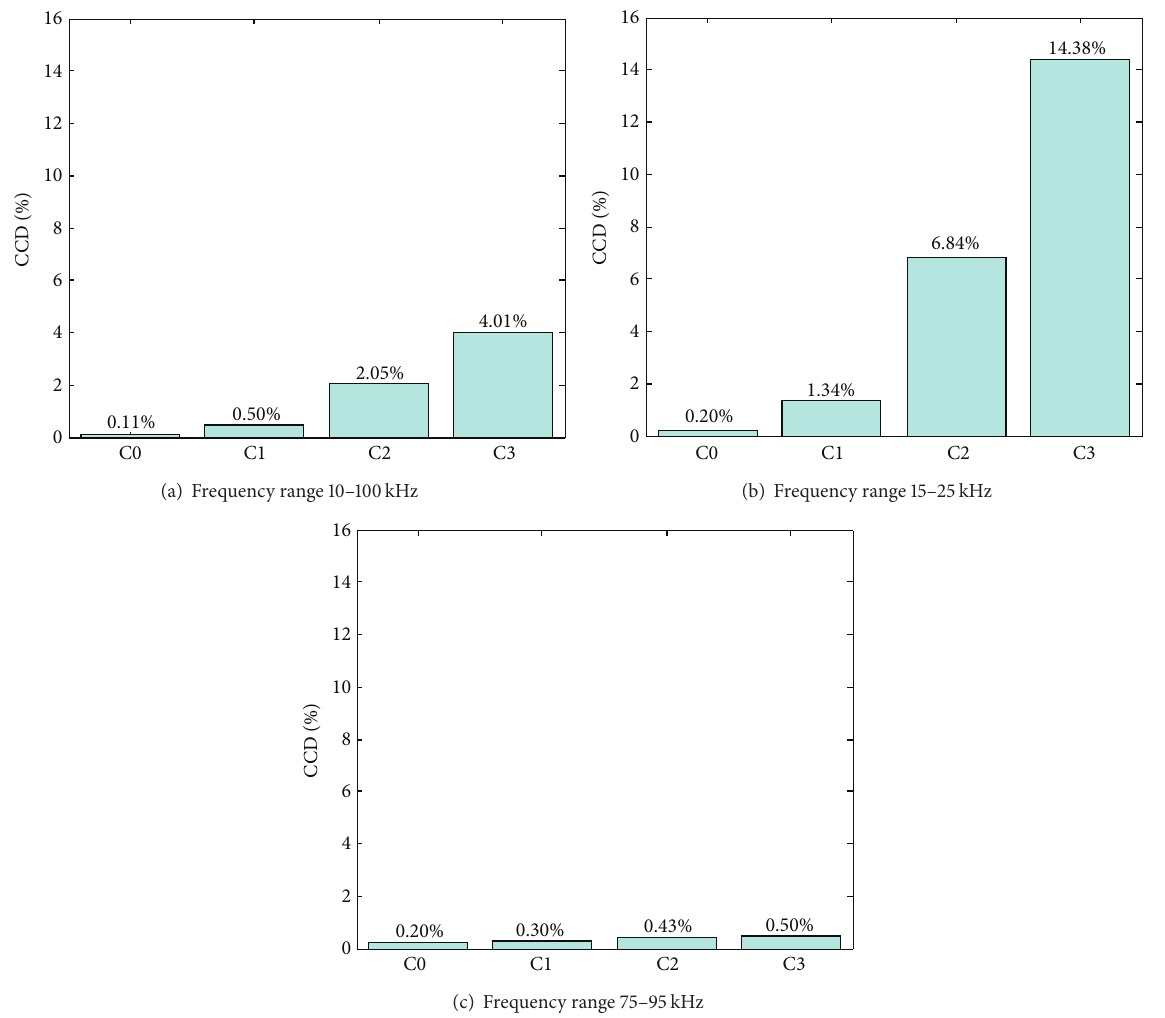
Figure 10: Contact stiffness monitoring by CCD